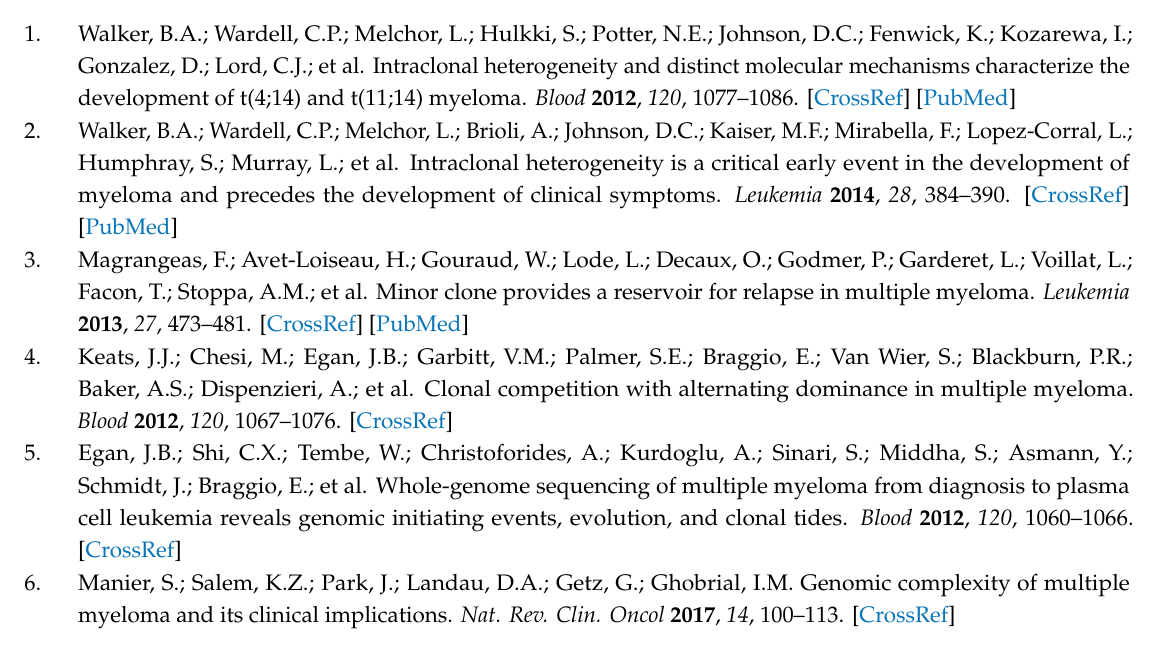
Figure 2b, Figure S3: Association between cell proliferation rates and BUB1 protein levels in HMCLs, Figure S4: BUB1 knockdown reduces deviations from modal chromosome